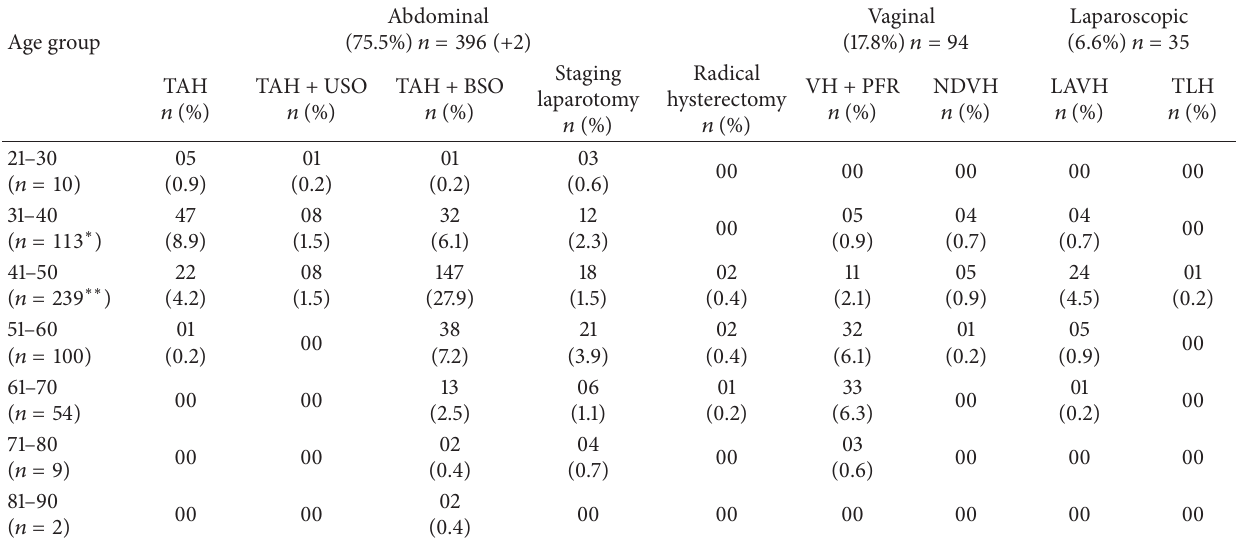
Table 1: Approach of hysterectomy in relation to age group of the women.